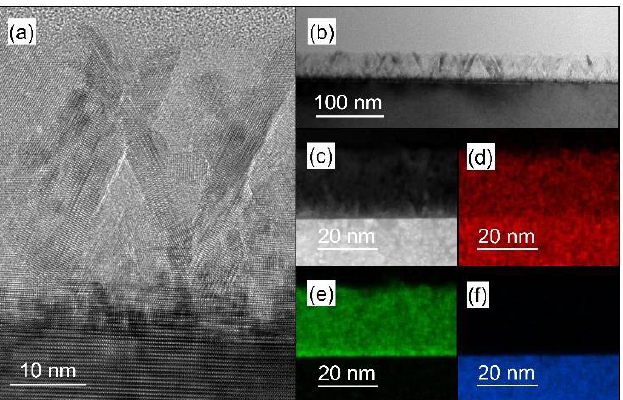
Figure 7. TEM cross-sections showing the LT AlN/high temperature GaN interface of samples A1, grown with DMHy. Two different magnifications are given in ( a – c ) showing a HAADF image. EDX images for N ( d ), Al ( e ), and Ga ( f ) are also shown.